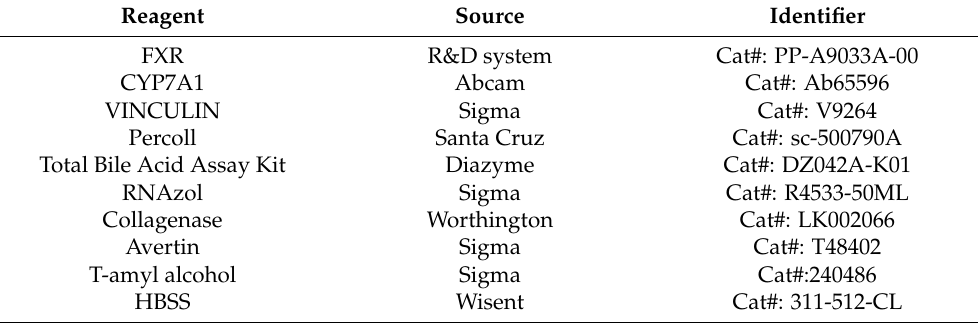
Table 4. List of